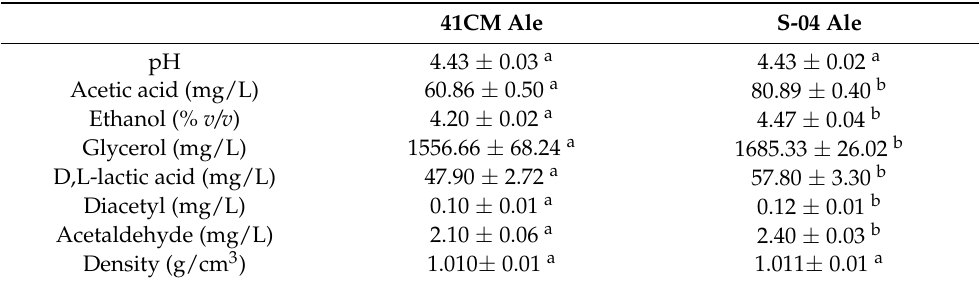
Table 1. Physicochemical parameters of the ale beers obtained using S. cerevisiae 41CM and S. cerevisiae S-04 starters. Different lowercase letters in each row represent significant differences ( p < 0.05). Results are shown as mean ± SD ( n =